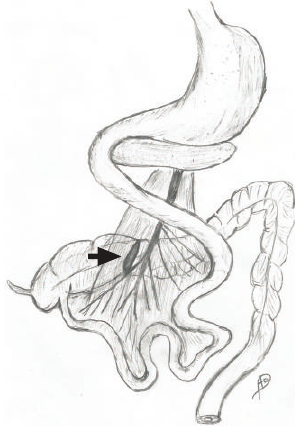
Figure 2: Operative photograph. Duodenum is located on the right side of the mesenteric root and extends as a direct continuation of the antrum, without being curved behind mesenteric axis.